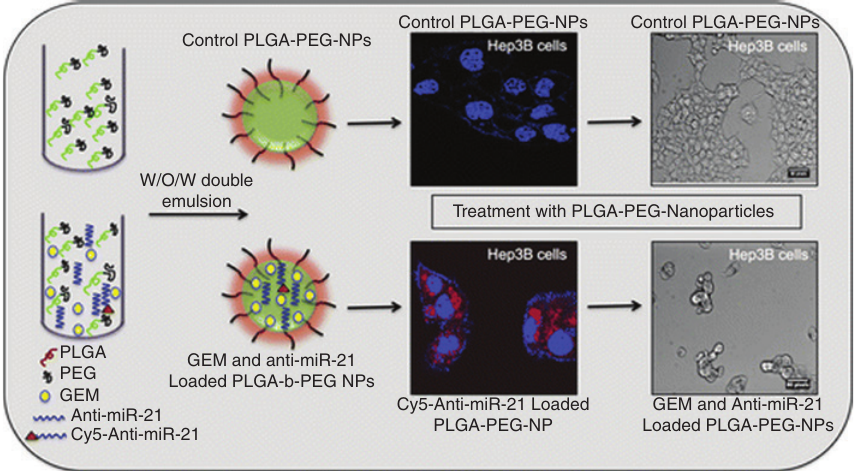
Figure 4: Water-in-oil-in-water (w/o/w) double emulsion method was used to coload antisense-miRNA-21 and GEM in PEGylated-PLGA-NPs. These co-encapsulated nanoparticles revealed increased treatment efficacy in HCC cells, compared to cells treated with either antisense- miRNA-21- or GEM-loaded NPs at equal concentration, indicating that down-regulation of endogenous miRNA-21 function can reduce HCC cell viability and proliferation in response to GEM treatment. Reprinted with permission from Devulapally [63]. Copyright (2016) American Chemical